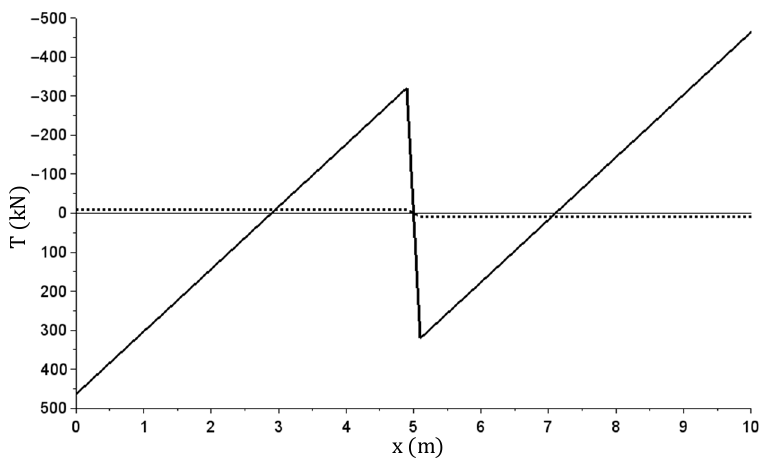
Figure 25. The T(x) (kN) shearing force graph—at maximum and after relief.